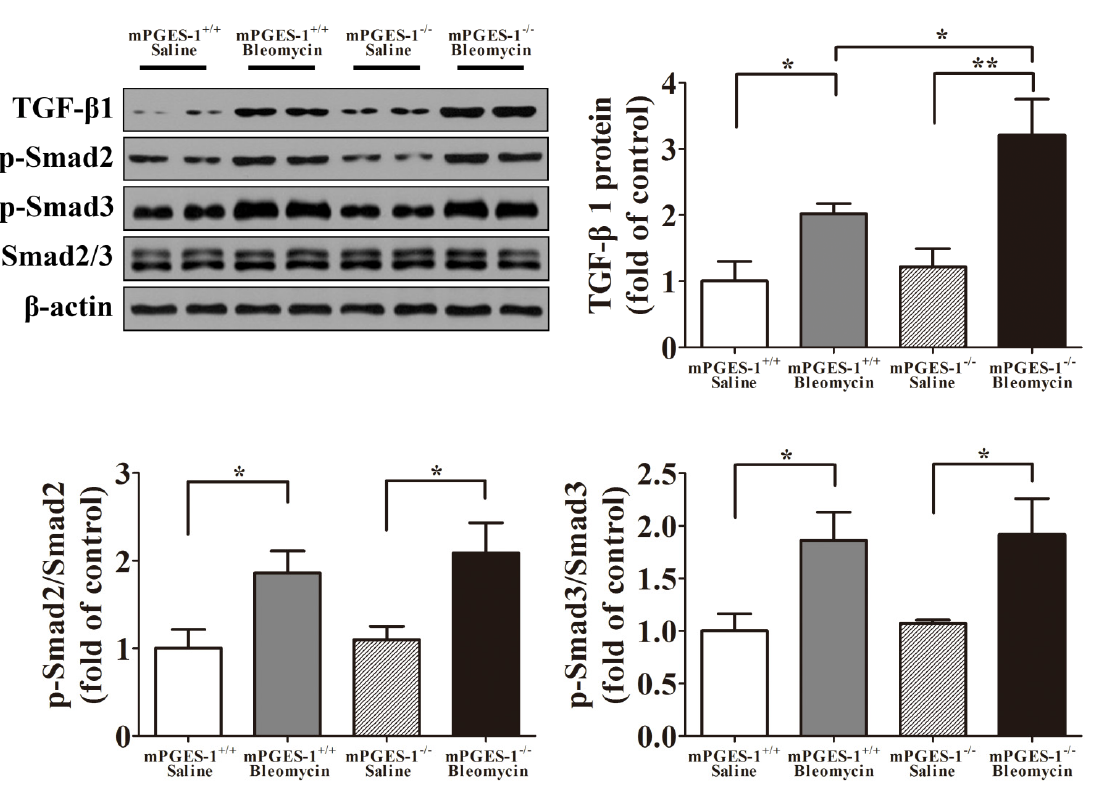
Figure 4. The representative western blot images and scanning densitometry of protein expression of TGF- β 1 and p-Smad2/3 in the lungs of mPGES-1 +/+ and mPGES-1 − / − mice after administration. Results are expressed as means ± SEM ( n = 4–6 mice per group) ( * p < 0.05, ** p <